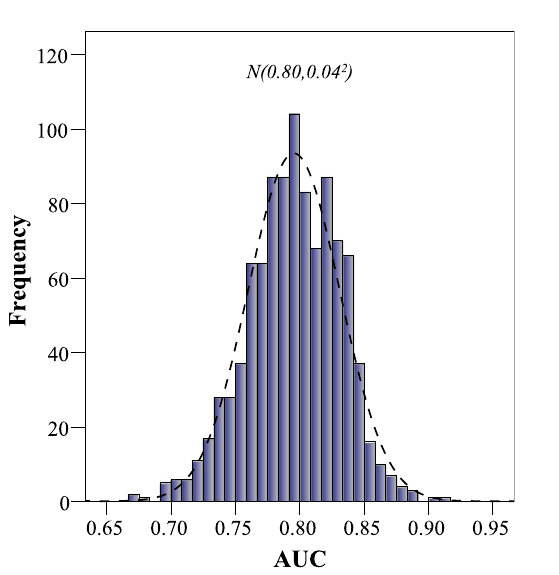
Figure 3. Area under the Receiver Operating Characteristic curve distribution for the validation of our scoring system using the bootstrap method. Abbreviations: AUC, area under the Receiver Operating Characteristic curve; CI, confidence interval.